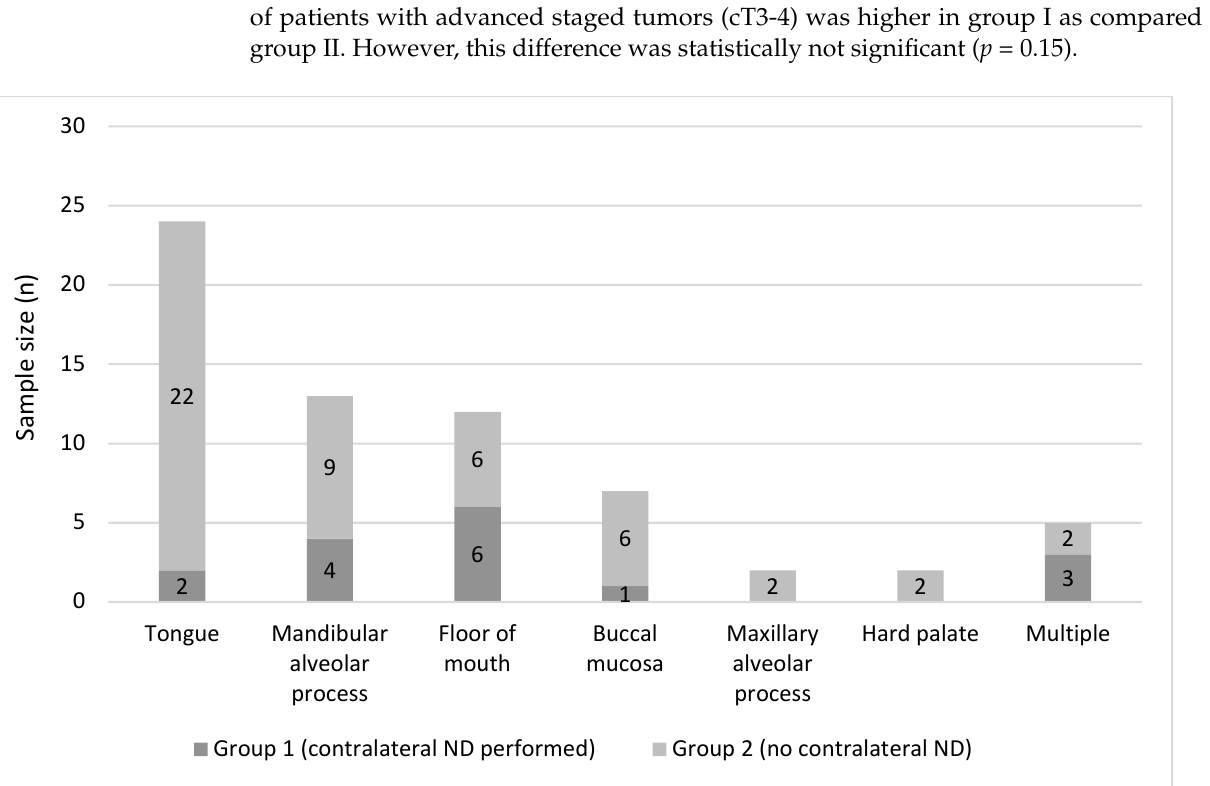
Table 2. Histopathological examination.